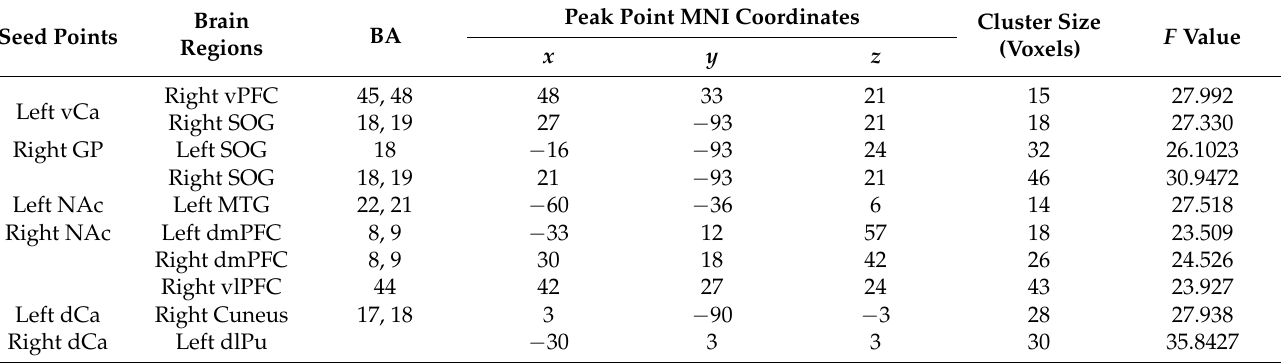
Table 2. Anatomical locations of significant Group × Time interaction on the striatal-based